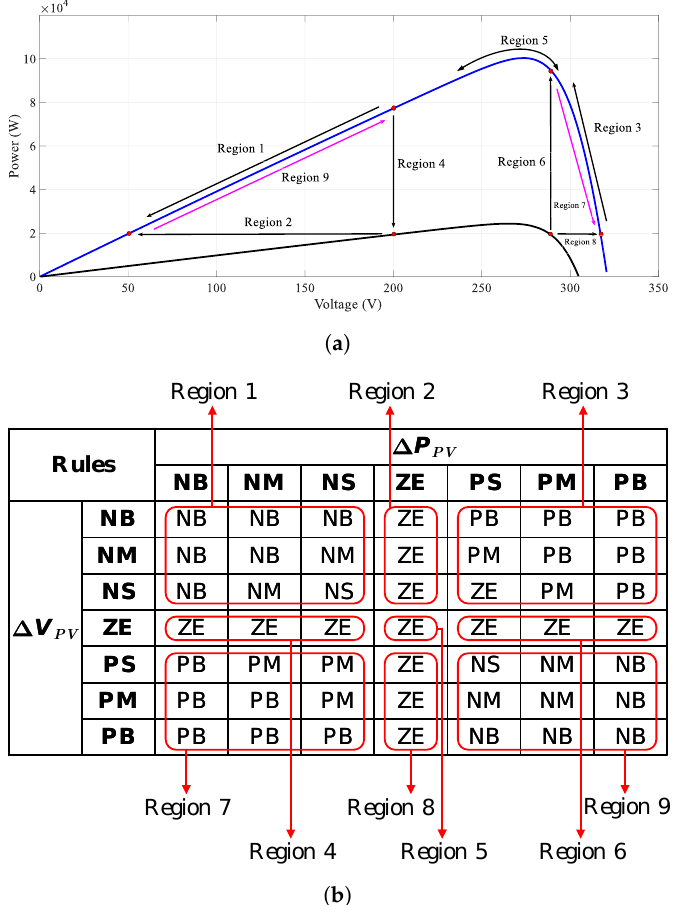
Figure 10. ( a ) Fuzzy regions for P PV − V PV curve; ( b ) Fuzzy rules for algorithm using ∆ V PV and ∆ P PV as the inputs.